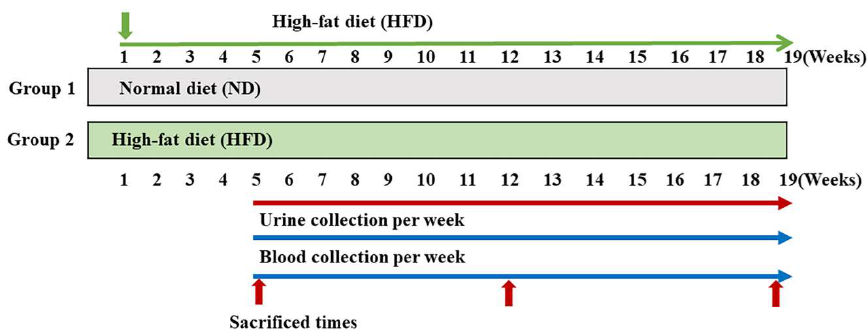
Figure 5. Experimental design. After 1 week of acclimatization, Zucker diabetic fatty (ZDF) rats were randomly split into two groups: one group received a standard chow diet (ND group, n = 6) and another received a high-fat diet (HFD group, n = 18). ND, normal diet; HFD, high-fat diet.